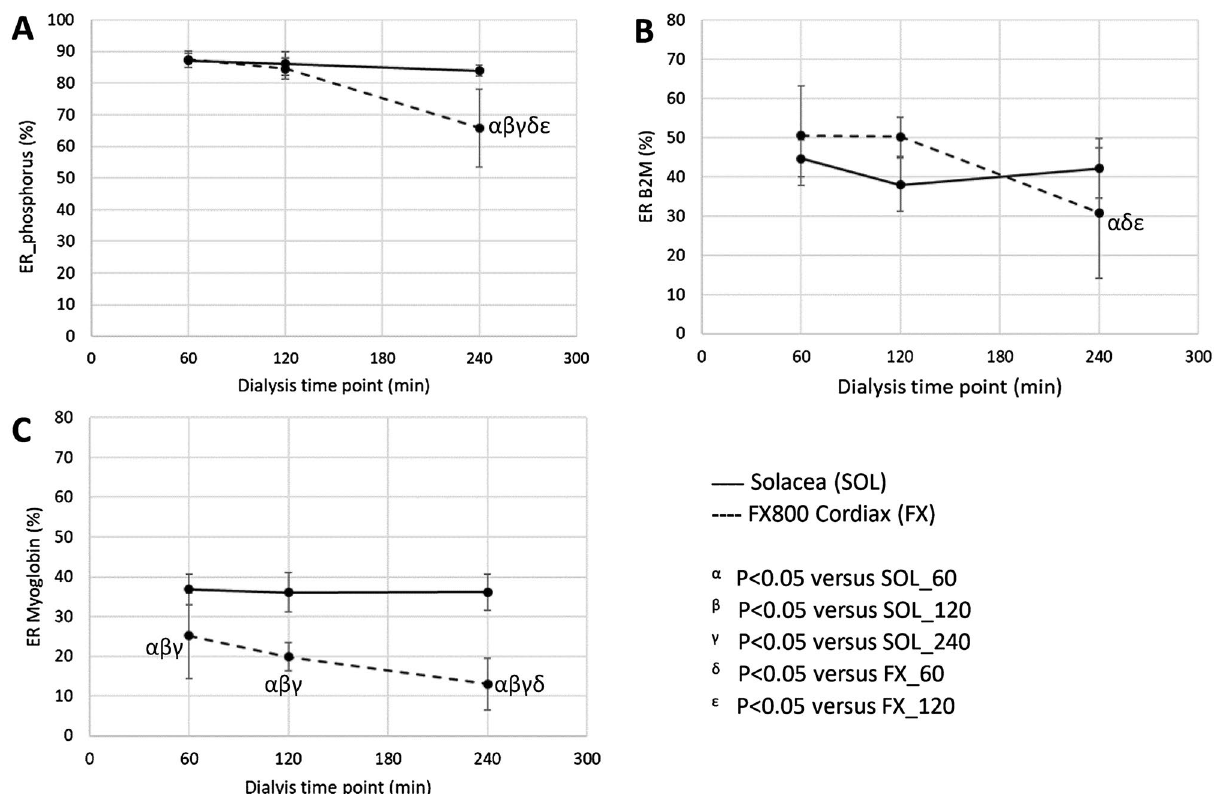
Figure 2. Extraction ratio (ER) of phosphorus (panel A ), beta-2-microglobulin (panel B —B2M) and myoglobin (panel C ) as measured in 10 patients at the end of a dialysis session with different durations (i.e. 60, 120 and 240 min) and with the Solacea (full line) and the FX800 CorDiax dialyzer (dashed line) ( n =